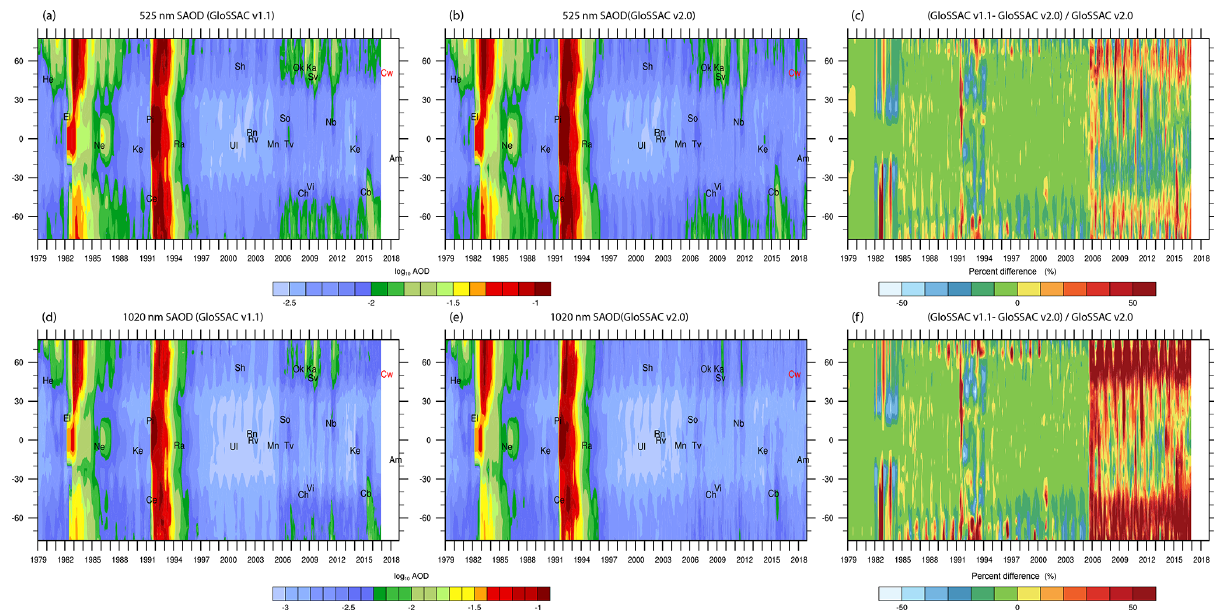
Figure 15. Latitude versus monthly time series of SAOD at 525 and 1020nm: (a) using GloSSAC v1.0; (b) using merged OSIRIS bias- corrected version 7.0, bias-corrected CALIOP, and SAGE III/ISS data (GloSSAC 2.0); and (c) percent difference between (a) and (b) . Panels (d) , (e) , and (f) are same as (a) , (b) , and (c) but for 1020nm extinction. For 525nm extinction, OSIRIS data are bias corrected using monthly pseudo Ångström exponents shown in Fig. 5, while CALIOP 525nm extinction is inferred using the OSIRIS 525nm extinction to CALIOP 532nm backscatter ratio. For 1020nm, OSIRIS data are bias corrected using monthly pseudo Ångström exponents shown in Fig. 11, while CALIOP 1020nm extinction is inferred using the OSIRIS 1020nm extinction to CALIOP 532nm backscatter ratio.